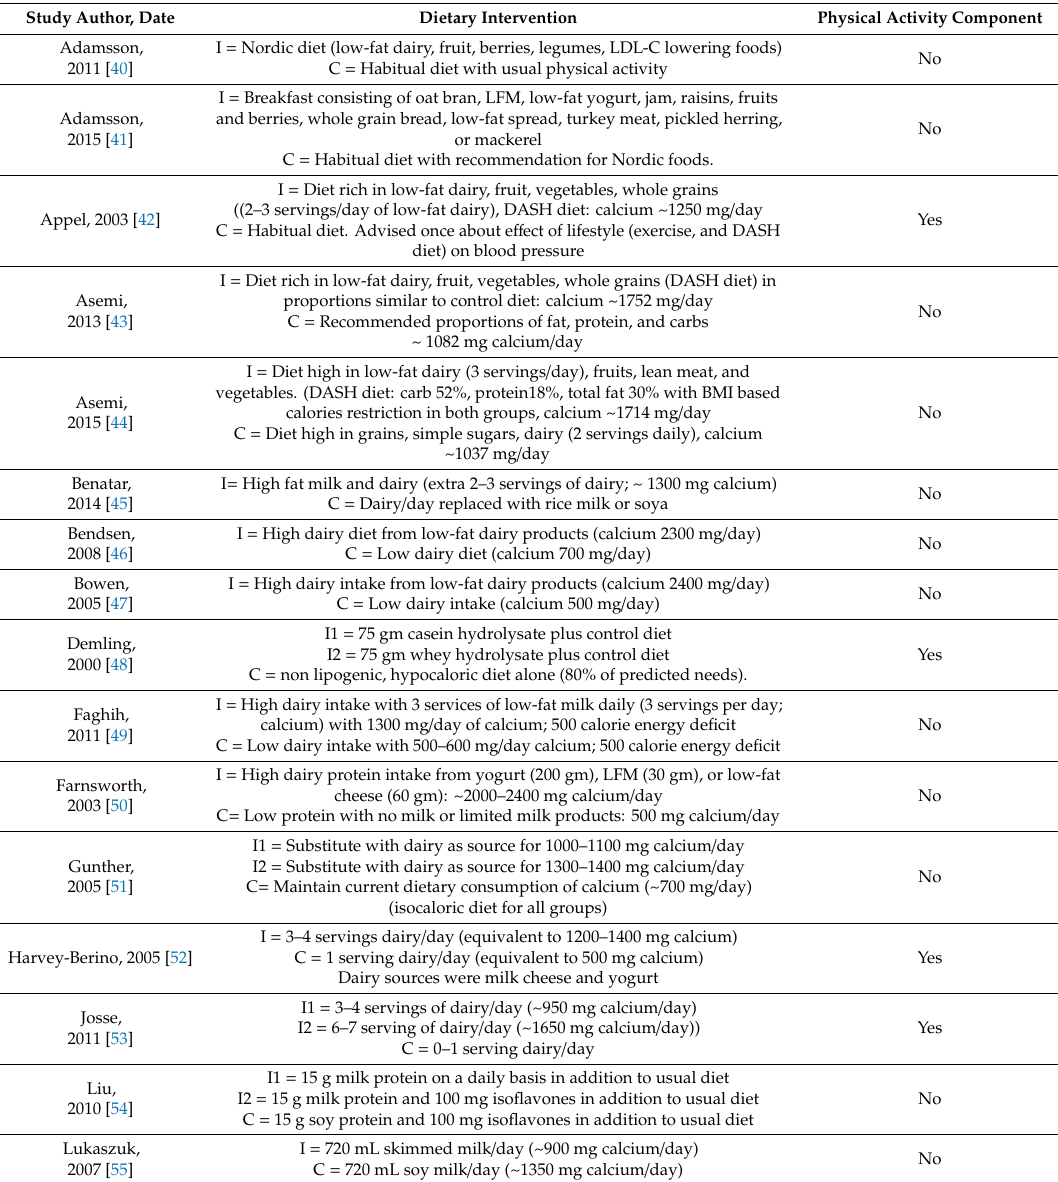
Table 2. Description of intervention and control diet for studies in the